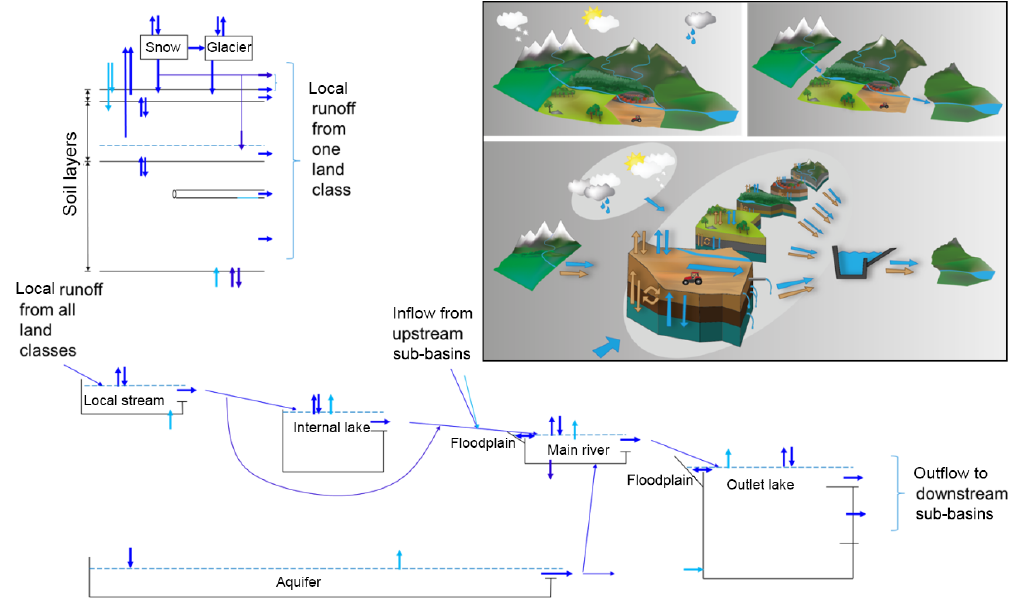
Figure 4. Schematic concept of the HYPE model (all equations are available at http://hypecode.smhi.se/, last access: 30 July 2018).